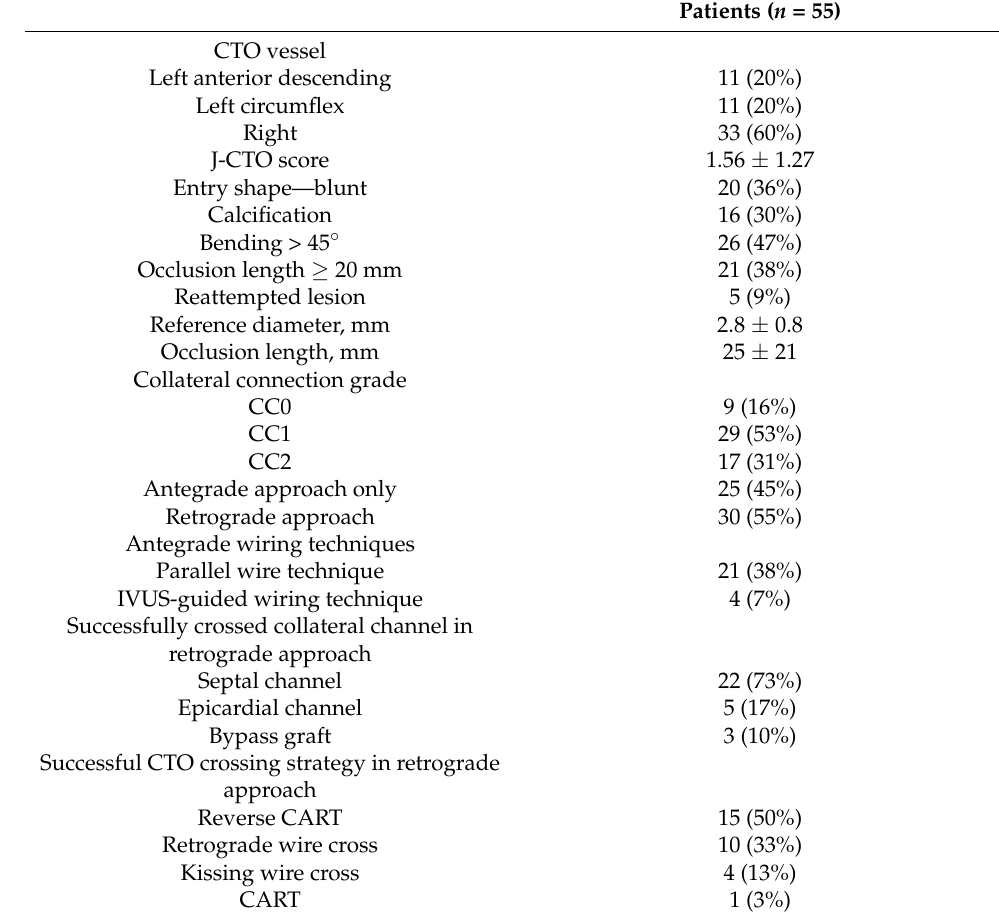
Table 2. Angiographic and procedural characteristics.